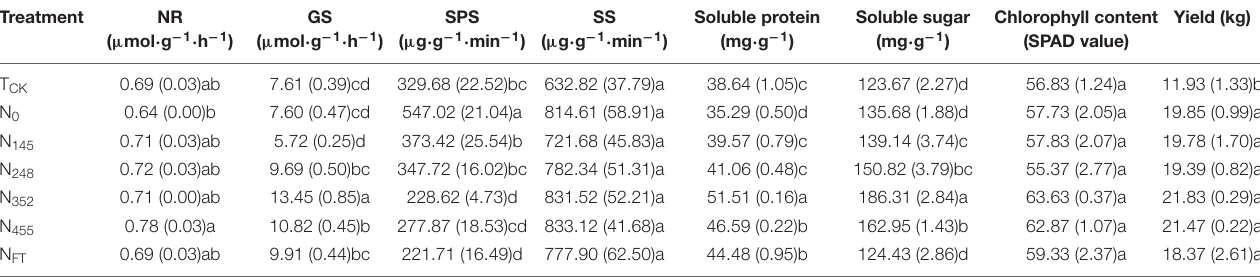
TABLE 2 | Leaf physiological attributes and yield of banana under different nitrogen fertilization rates.